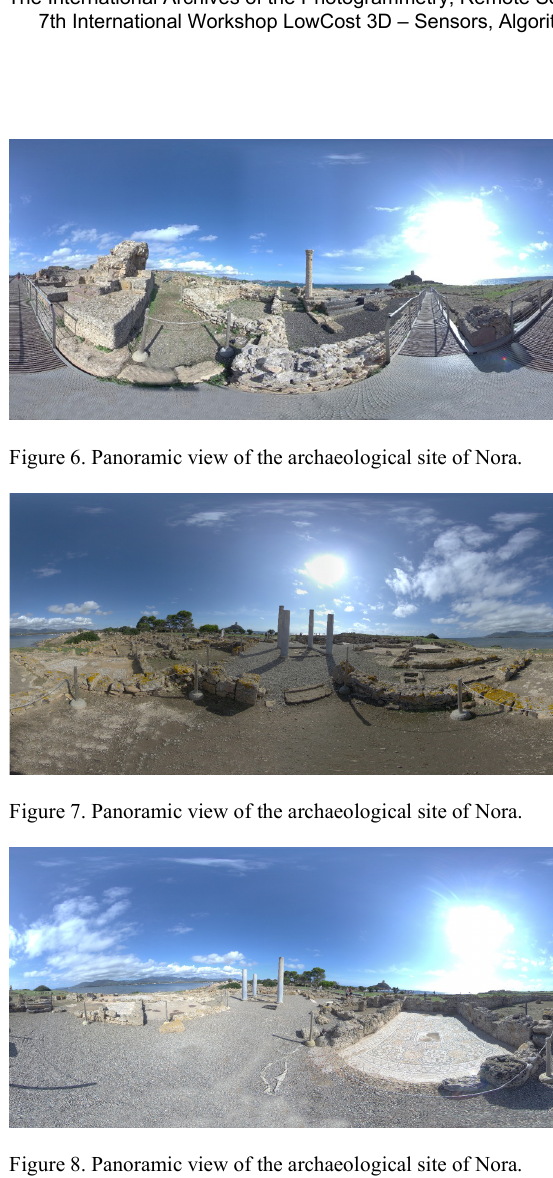
Figure 8. Panoramic view of the archaeological site of Nora.